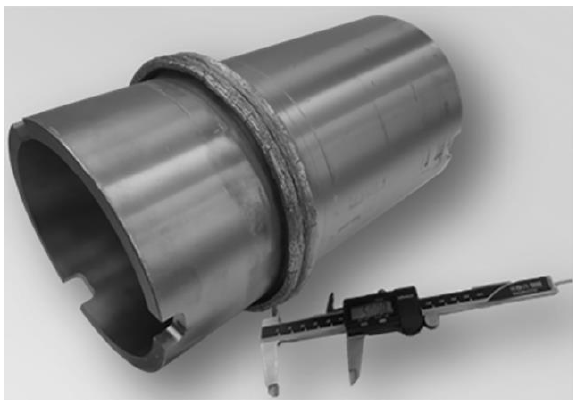
Figure 18. Medium-size friction welded Mo-tube (OD: 150 mm, ID: 130mm) [46].